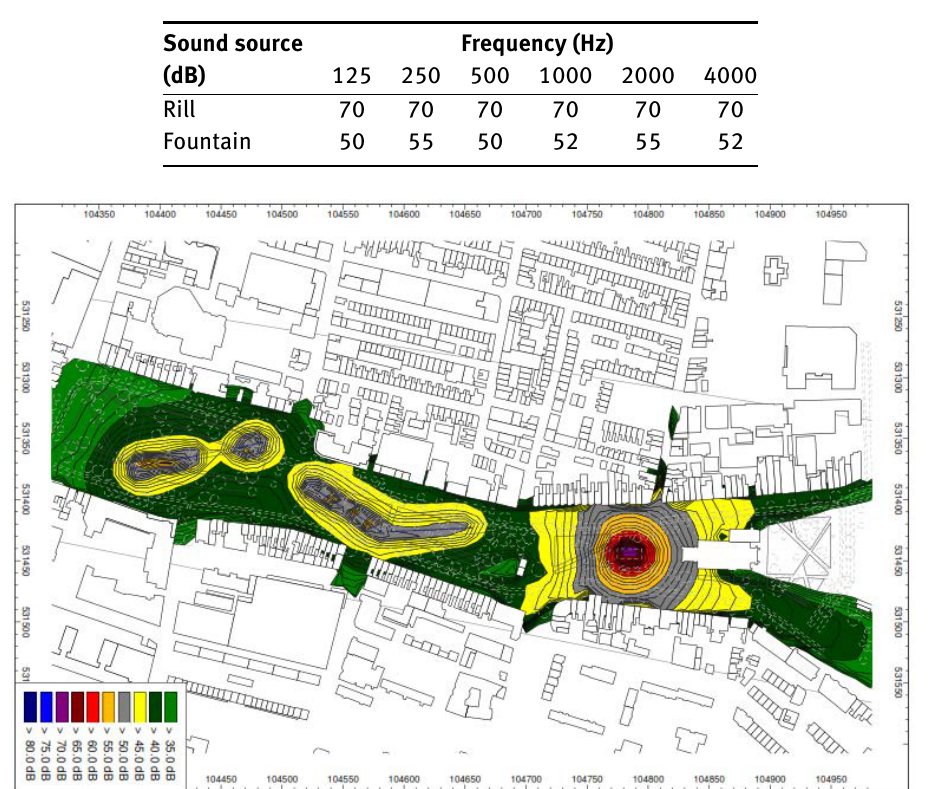
Figure 4: Sound map calculated for water feature sound sources’ spatial distribution (L day